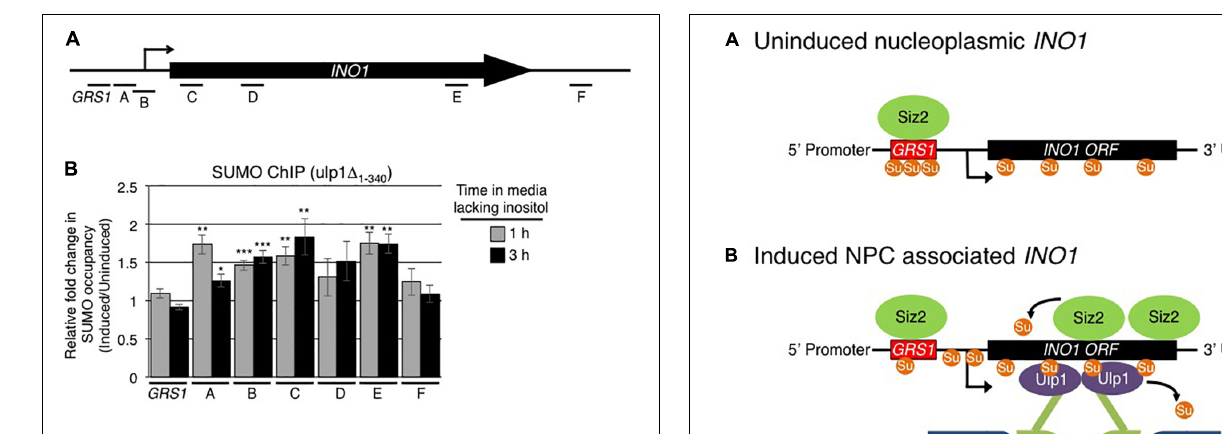
FIGURE 8 | Ulp1 regulates sumoylation levels of proteins associated with the INO1 ORF. (A) Diagram of the INO1 locus and regions detected by ChIP analysis (see Figure 1A ). (B) ulp (cid:49) 1 − 340 cells were subjected to ChIP analysis using antibodies directed against the SUMO polypeptide (anti-SUMO antibody) prior to and at 1 and 3 h post induction of INO1 . qRT-PCR was used to quantify levels of DNA corresponding to the various regions of INO1 (see panel A ) bound to sumoylated proteins. Shown are the relative fold changes in the occupancy of sumoylated proteins associated with the various regions of INO1 at the indicated times after induction relative to the uninduced samples. Results are the means ± SEM of five biological replicates. Asterisks indicate a significant difference relative to uninduced as determined by a Student’s paired t -test. * p < 0.05, ** p < 0.01, *** p < 0.001.